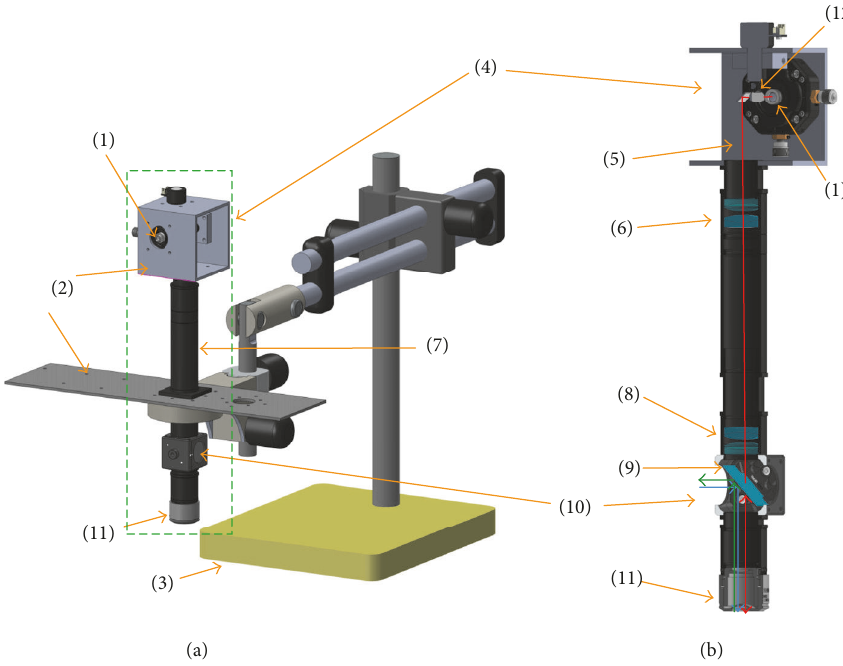
Figure 2: Sample arm. This image demonstrates the design of the sample arm that is mounted on a typical microscope stand. This system uses two identical semi-Pl¨ossl lenses as scan and tube lenses. The cross section shows the optics including galvanometric mirrors, scan and tube lens mechanisms, and the infrared dichroic mirror. (1) OCT collimator, (2) custom mounts, (3) commercial microscope stand, (4) scan head, (5) OCT beam, (6) scan lens, (7) lens tube, (8) tube lens, (9) dichroic mirror, (10) visible port, (11) objective lens, and (12) galvanometric mirrors. The SOLIDWORKS designs of lens tubes and cage cube-mounted beam splitters are adapted from Thorlabs (Thorlabs, NJ, USA). The microscope stand model has been modified from